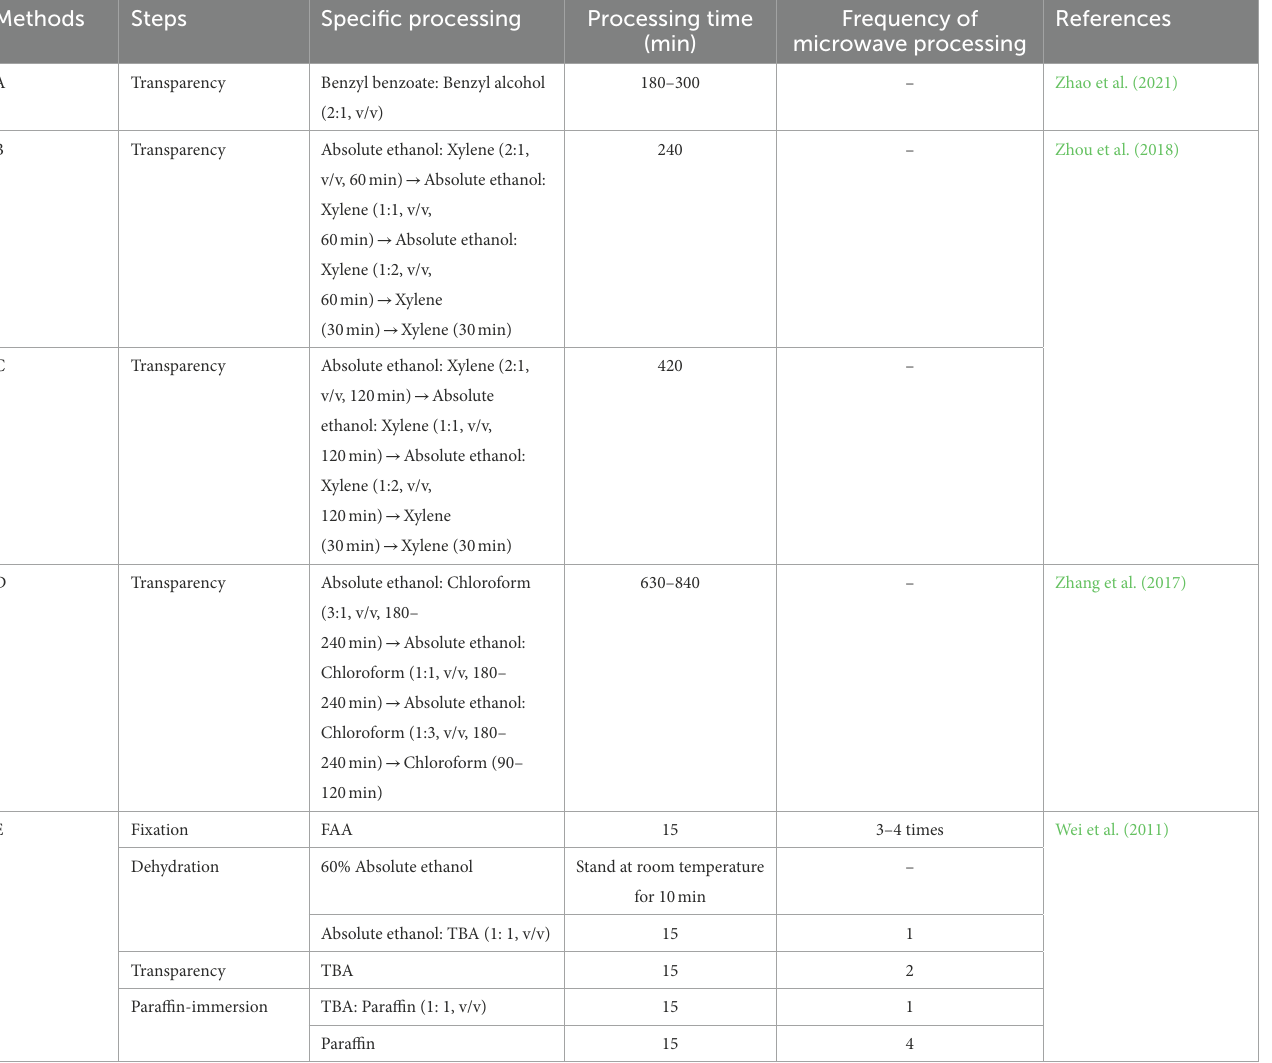
TABLE 1 The processing method of root system samples of Chinese fir